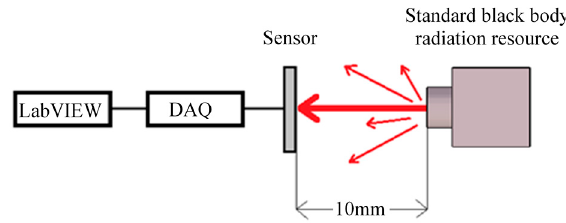
Figure 7. Measurement of radiation absorption for the sensors.